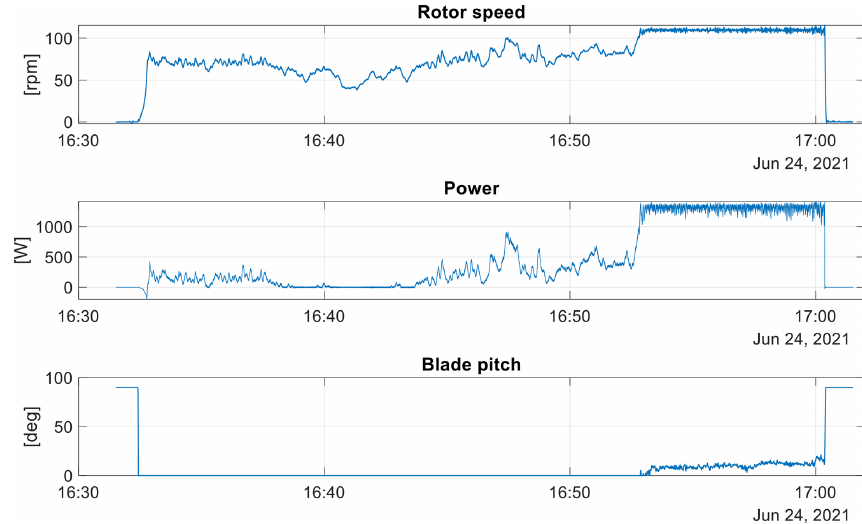
Figure 5. An example of time history with both a below- and an above-rated regime (time zone: CEST).